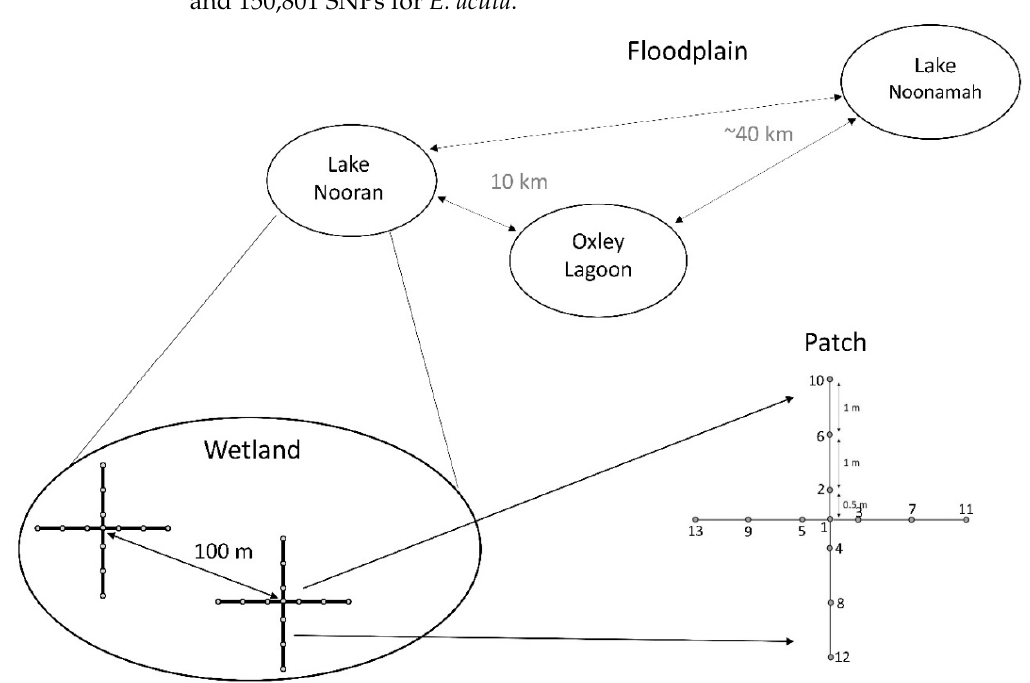
Figure 2. Conceptual diagram showing the three wetlands used in this study, how patches were arranged within each wetland, and how samples were collected within each patch.